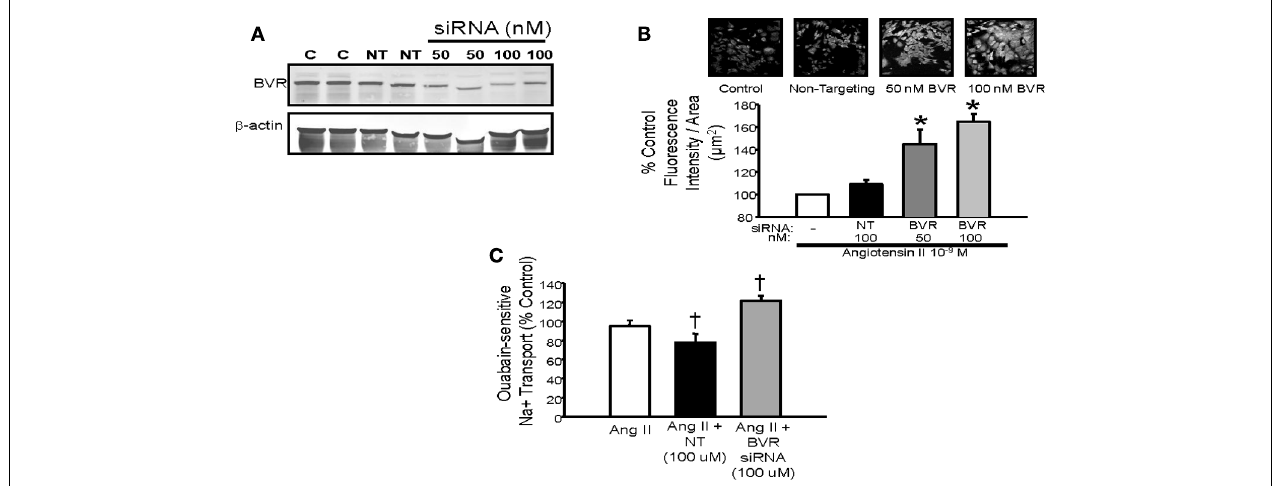
panel – treatment with 50 or100 nM BVR siRNA resulted in significant increase in DHE staining. (C) Effect of BVR siRNA treatment on ouabain-sensitive sodium transport in cultured mouseTALH cells. BVR siRNA significantly increase Ang II-mediated sodium transport. * P < 0.05 as compared control. † P < 0.05 vs. Ang II. Figure modified fromYoung et al.